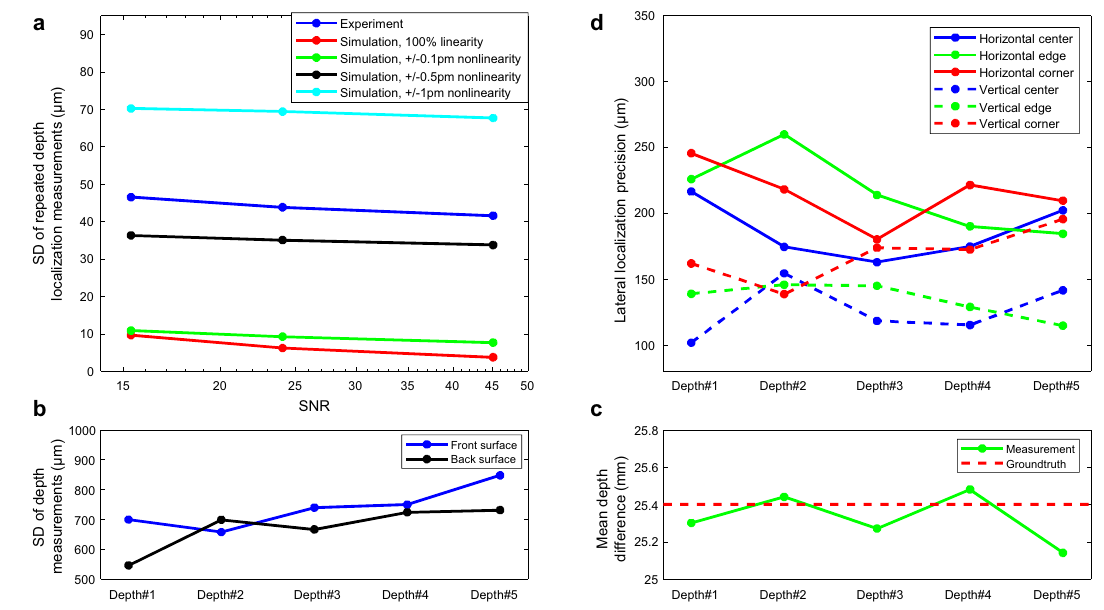
Fig. 3 Results of system localization precision and accuracy characterization. a Measured axial localization precision calculated from the standard deviation (SD) of repeated depth measurements at the “ same spot ” in the grating scan direction, using an ideal mirror sample. Also plotted are the theoretical axial localization precisions with various wavenumber nonlinearity coef fi cients (0, ±0.1, ±0.5 and ±1 pm) at three different signal-to-noise ratios (SNRs). Measured axial localization b precision and c accuracy calculated from the SD of depth measurements from multiple “ scanning spots ” along two lines in the galvanometer scan direction using a diffuse scattering sample (two staggered anodized aluminum plates). Plotted are b the SD of the depths of the front and back surfaces of the plate and c the mean depth difference at fi ve different depths (~4, 10, 16, 22, and 28 cm). d Horizontal and vertical localization precisions at three different depth locations (~4, 10, 16, 22, and 28 cm) and three different lateral positions (center: ~[0,0] cm; edge: ~[10,0] cm; corner: ~[10,10] cm) within the measurement fi